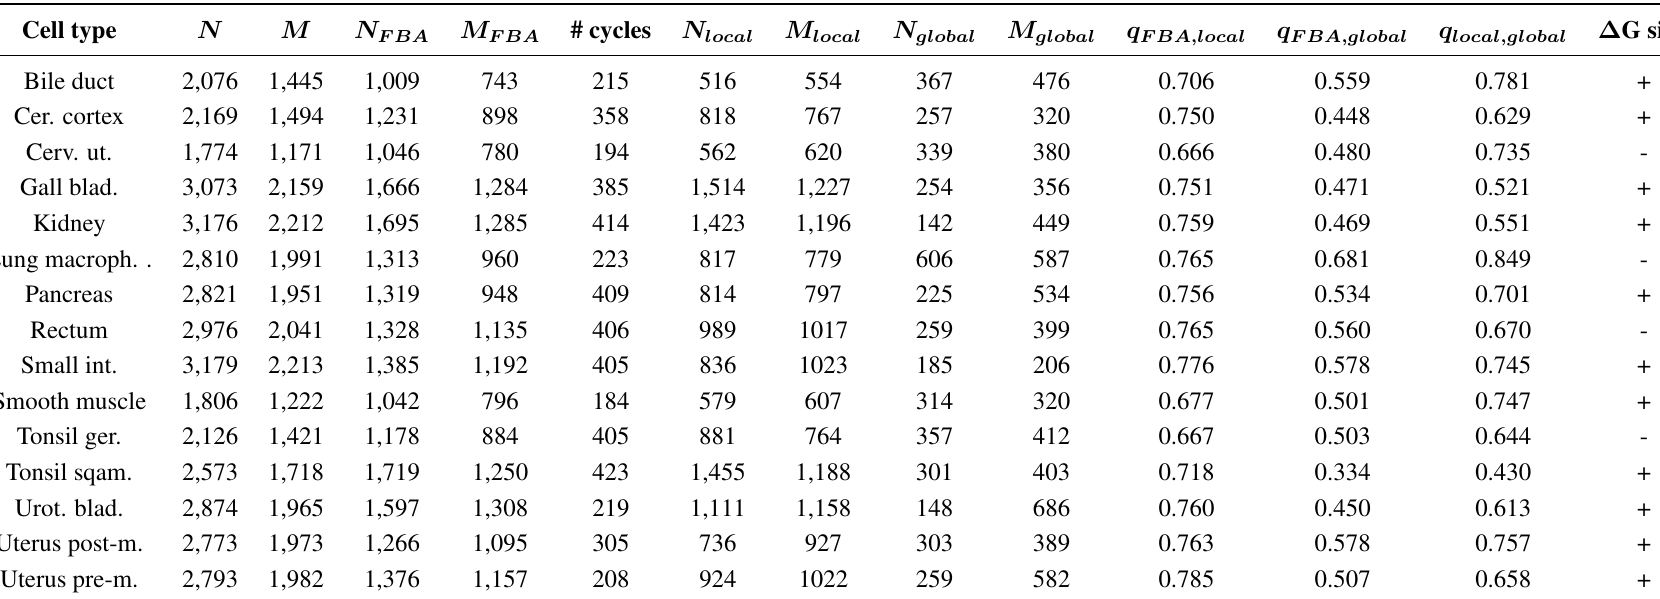
Table 1. Overview of the results obtained for the human tissue-specific metabolic networks (with the biomass objective function). Columns are as follows. Cell type: abbreviations for the tissue-specific metabolic networks examined, for the full names please refer to the text (head of Section 3.2). N and M : overall number of reactions and metabolites appearing in the network. N number of active reactions and produced/consumed metabolites in the Flux Balance Analysis (FBA) solution. # cycles: number of cycles that the local strategy needs to correct. N and M : number of active reactions and produced/consumed metabolites in the FBA local local solution corrected by the local strategy. N and M : the number of active reactions and produced/consumed metabolites in the global global FBA solution corrected by the global strategy. q : overlap between the FBA solution and the solution corrected by the local FBA,local strategy. q : overlap between the FBA solution and the solution corrected by the global strategy. q FBA,global FBA solution corrected by the local and global strategies. ∆ G sign: sign of the free energy difference obtained for the ATP hydrolysis in the solution obtained via the global correction